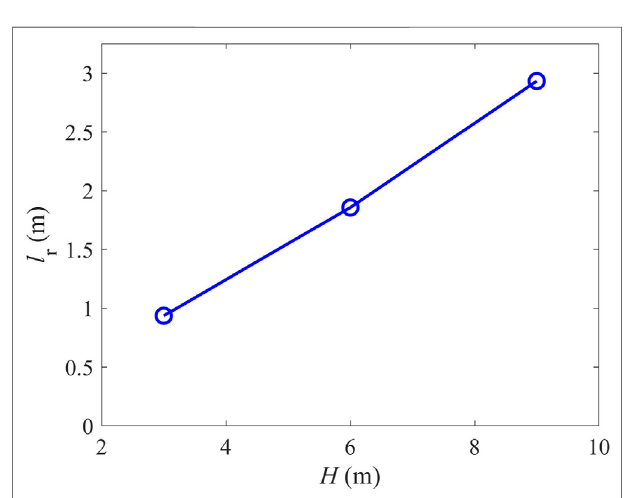
FIGURE 10 | Length of the region with no deposited fi rebrands vs. structure height for L (cid:3) W (cid:3) 3 m.